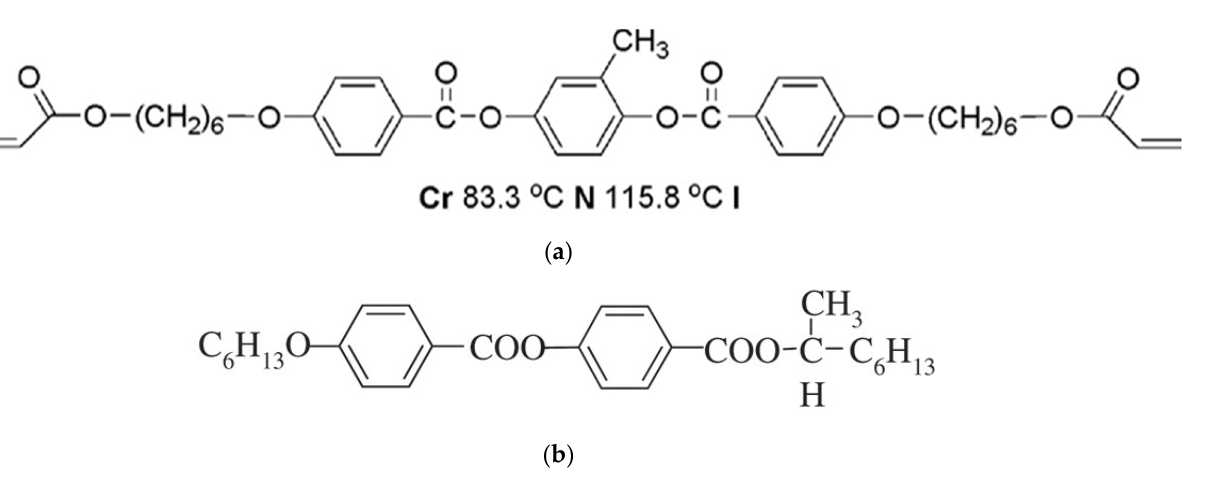
Figure 1. Chemical structure of LC monomer (C6M) and the chiral dopant (S811). ( a ) LC monomer. ( b ) Chiral dopant.